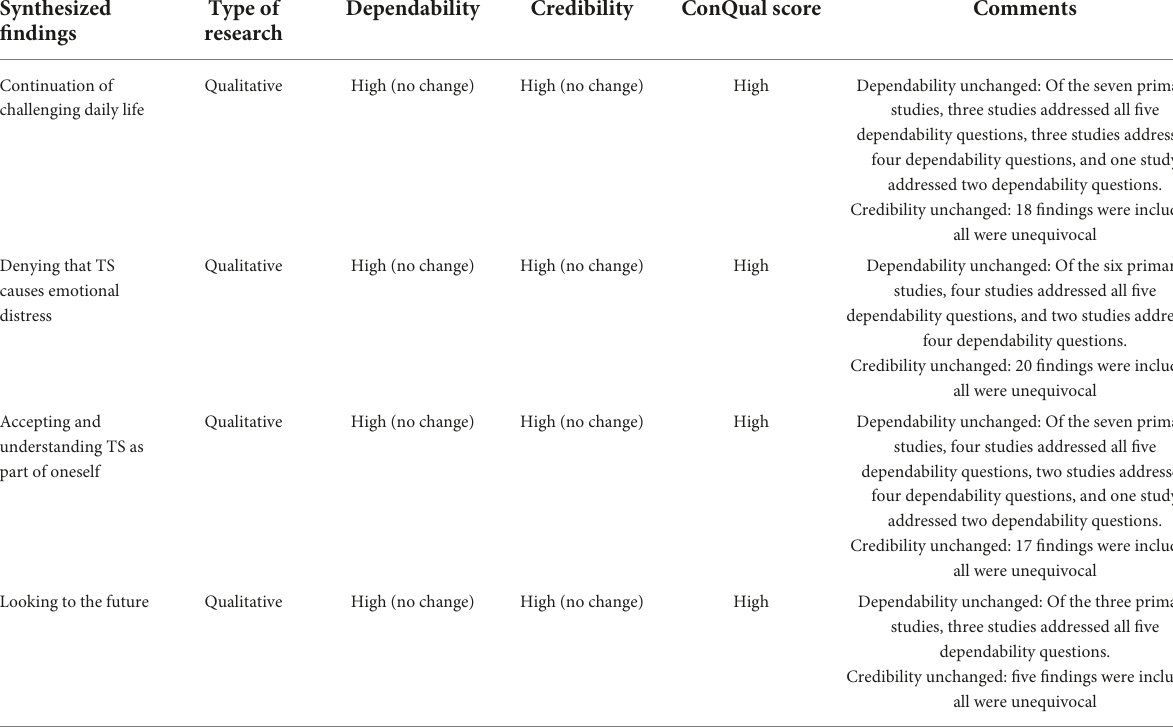
TABLE 4 Summary of the findings and ConQual